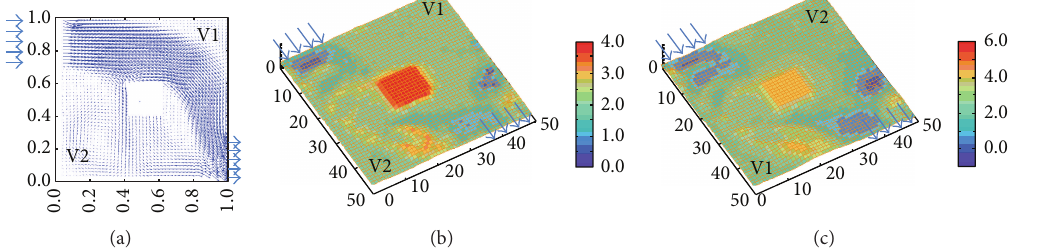
Figure 10: Sand ripples formation under with barrier (obstructs) model. (a) Air velocity distribution; (b) and (c) are sand bed morphology at 20th and 130th step